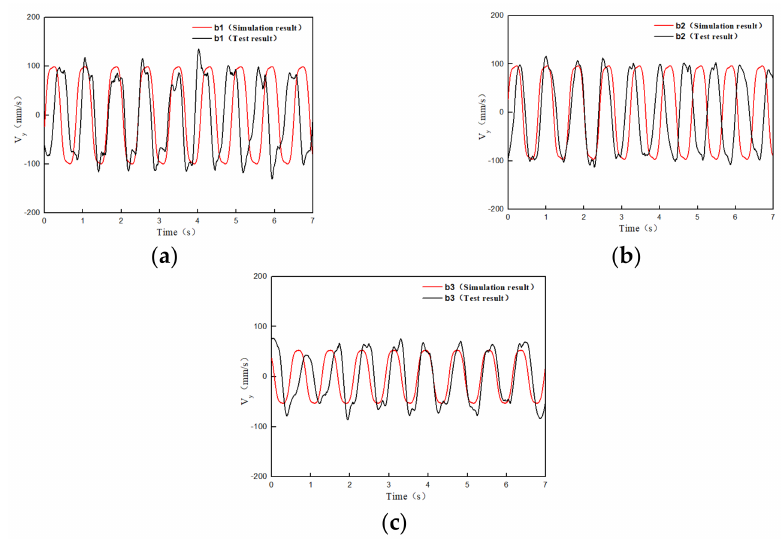
Figure 19. Comparison diagrams of the transverse velocity–duration curves between model test and numerical simulation, measured at points: ( a ) b1; ( b ) b2; ( c ) b3. The periodic successive separation of the boundary layer around the pier leads to a dynamic pressure difference on both sides of the pier. F L , which is the force perpendicular to the flow direction of the pier, fluctuates, and its fluctuation frequency is consistent with the wake vortex shedding frequency and transverse flow velocity fluctuation frequency. In this study, the fluctuation period of the lift coefficient C L = F L around the flow was found 0.5 ρ V 2 D to be 0.8 s through simulation (Figure 20), which is consistent with the experimental result of 0.78 s discussed in Section 3.1.2. Here, V is the river velocity, and D is the characteristic length of the blunt body.